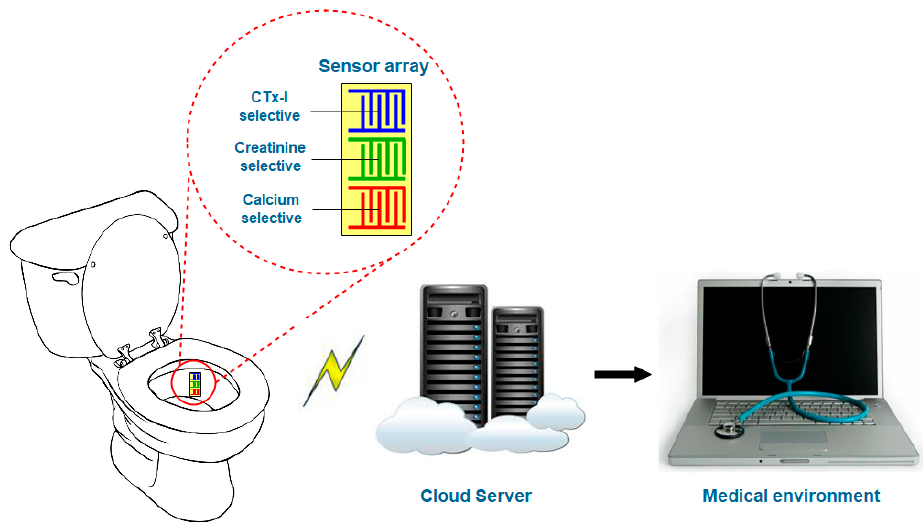
Figure 11. Schematic diagram of the possible smart toilet for continuous monitoring of bone loss.